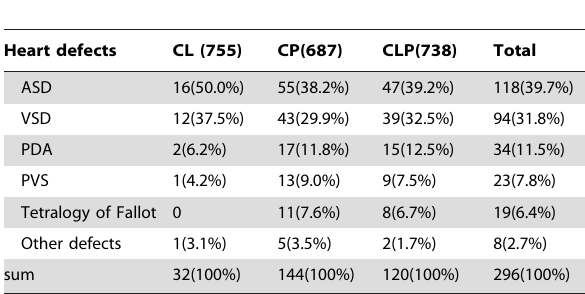
Table 3. Distribution of malformations by affected organ systems in different type of clefts.